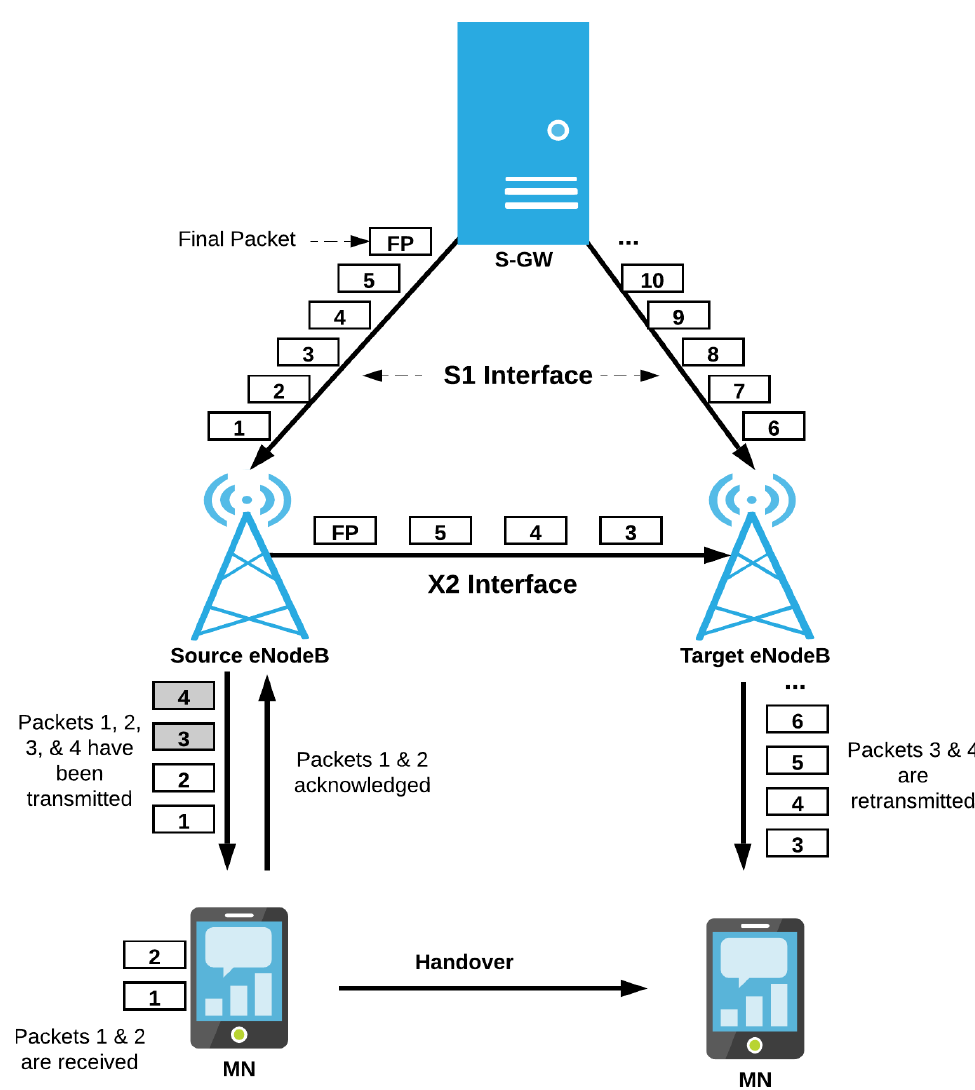
Figure 3. Lossless